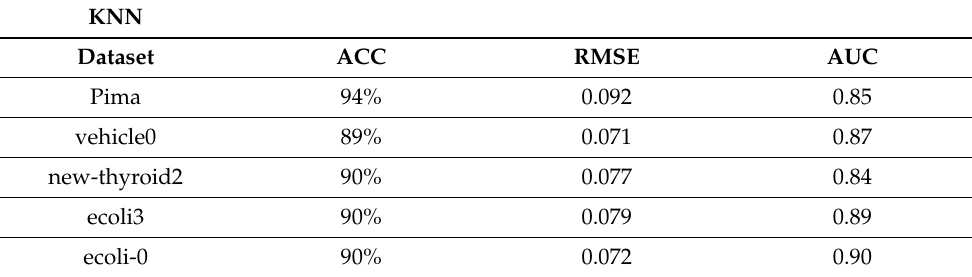
Evaluation results for the proposed algorithm to handle the imbalanced class problem—KNN.